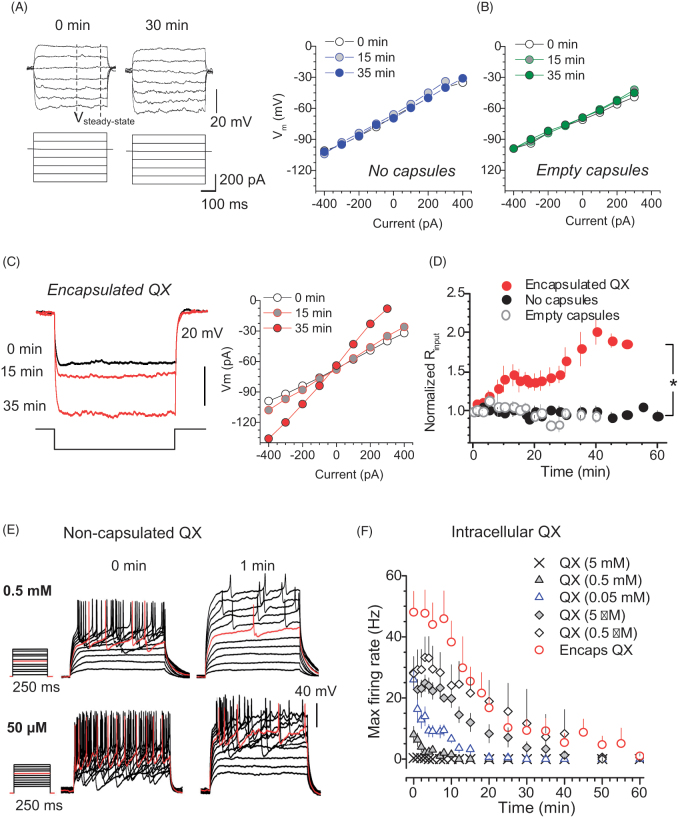
Encapsulated QX-314 gradually increases cell input resistance of neurons while reducing their firing rate in a dose-dependent manner. (A) Traces, examples of the membrane potential response (top) to current step pulses (bottom) in the same neuron (control condition, no microcapsules) at two time points, as indicated. Dashed lines, time window (stable response) where the input resistance was estimated. Graph, examples of the current–voltage relationship at three time points, as indicated, in control conditions. (B) Examples of the current–voltage relationship at three time points, as indicated, after the injection of empty microcapsules. (C) Traces, examples of the membrane potential response (top) to a current injection (bottom) at three time points after intracellular delivery of encapsulated QX-314, as indicated. Graph, examples of the current–voltage relationship at three time points, as indicated, for the same cell. (D) Time course of the cell input resistance in control (n = 14 neurons), post-infusion of empty microcapsules (n = 15) or encapsulated QX-314 (n = 14), as indicated. (E) Traces, representative recordings of neuronal firing after whole-cell dialysis with different concentrations of QX-314, at two time points, as indicated. (F) Time course of the maximum cell firing rate for different concentrations of free QX-314, compared with encapsulated QX-314, added to the intracellular medium, as indicated. Data are mean ± SEM; *p < .05 (unpaired t-test).